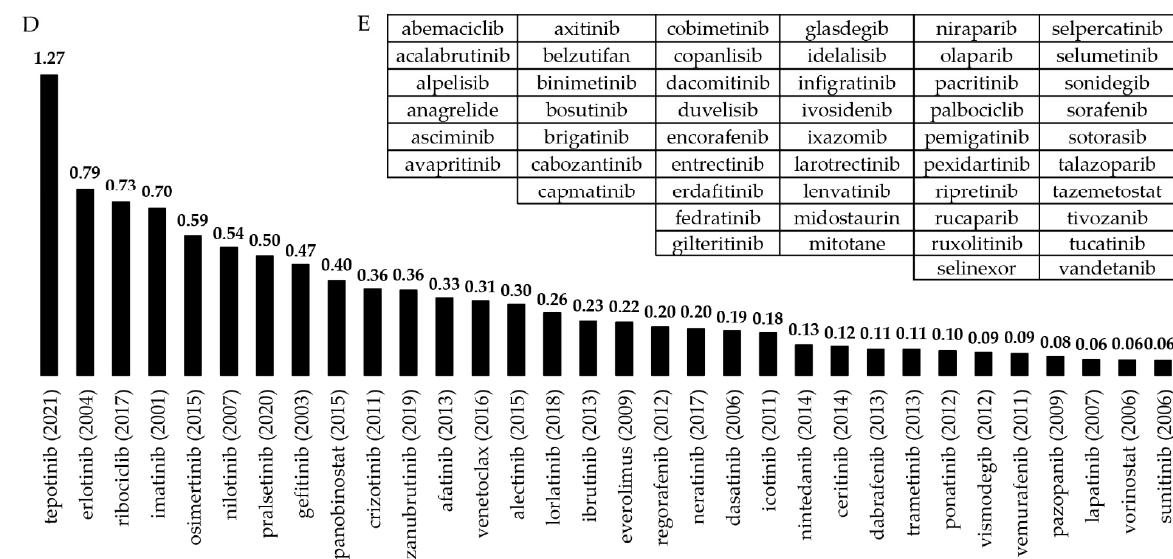
Figure 2. Summary of the results of the literature search. ( A ) Types of studies, ( B ) indications of monitoring, ( C ) monitored peripheral fluid spaces, ( D ) evaluation of clinical interest: number of manuscripts discussing the substance normalized to the number of years on the market, ( E ) marketed small-molecule, orally taken anticancer drugs with cellular protein targets without any example of being monitored in a peripheral fluid space. CSF, cerebrospinal fluid. Based on the number of relevant publications available on a specific OACD, normal- ized to the number of years it has been marketed, tepotinib (Tepmetko ® ) triggered the largest interest, followed by erlotinib (Tarceva ® ), ribociclib (Kisqali ® ), imatinib, and osimer- tinib (Tagrisso ® ), while the OACDs receiving the least attention were lapatinib (Tyverb ® ), vorinostat (Zolinza ® ) and sunitinib (Sutent ® , Figure 2, Table 3). Table 3. Clinical background of the monitoring of OACDs in peripheral fluid spaces. ALL, acute lymphoid leukemia; AML, acute myeloid leukemia; CNS, central nervous system; CSF, cerebrospinal fluid; CLL, chronic lymphoid leukemia; CML, chronic myeloid leukemia; NSCLC, non-small cell lung cancer; PBMC, peripheral blood mononuclear cells; PCNSL, primary central nervous system